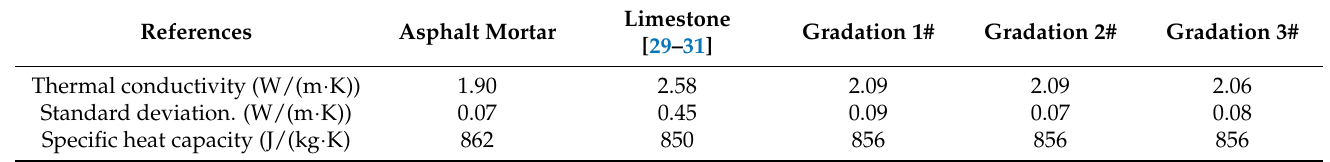
Table 1. Thermal property of materials used in simulation.